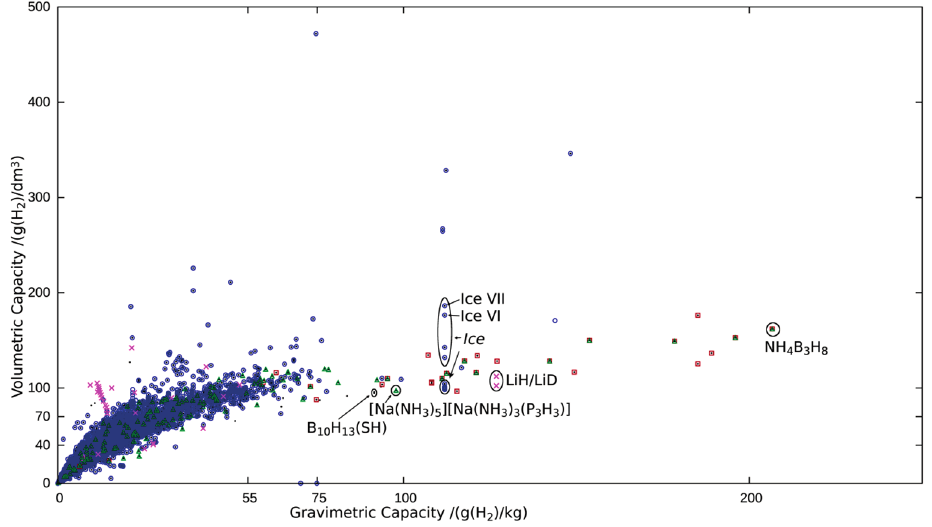
Figure 4. Plot of all inorganic hydrogen containing compounds in the COD (black dots). Selected subsets are emphasised: Binary hydrides (magenta crosses), nitrogen containing compounds (green filled triangles), boron-containing compounds (but excluding oxygen; red filled squares) and oxygen-containing compounds (blue filled circles). Some specific example compounds are labelled in the